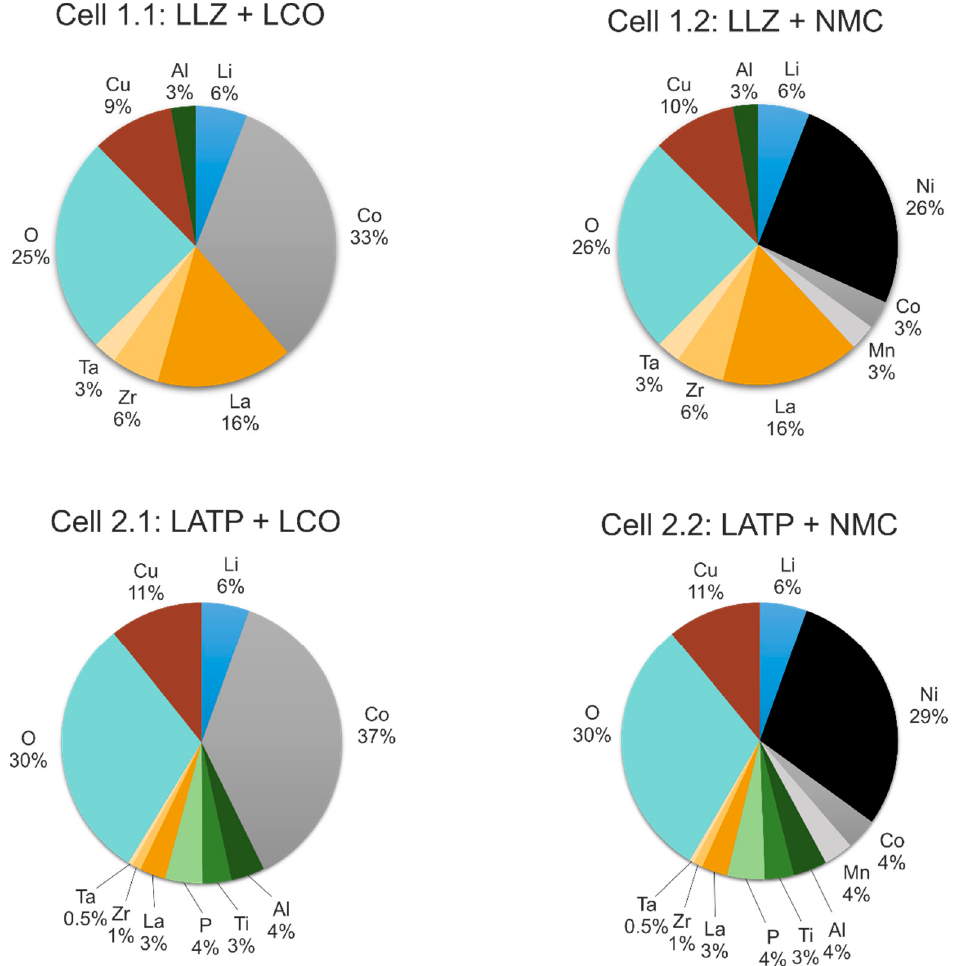
Figure 2. Material compositions of the four different cell designs. Table 2. Material demand required for 1 TWh ASB and share of demand on current world